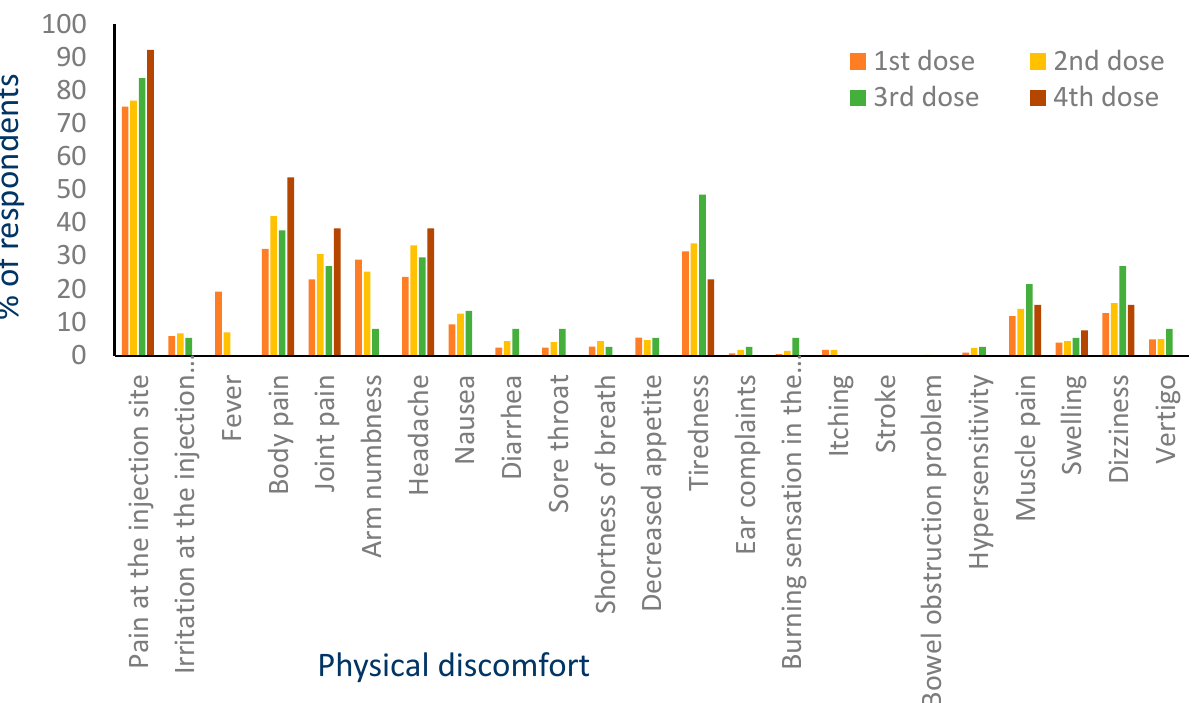
Figure 2. Distribution of side effects according to doses.